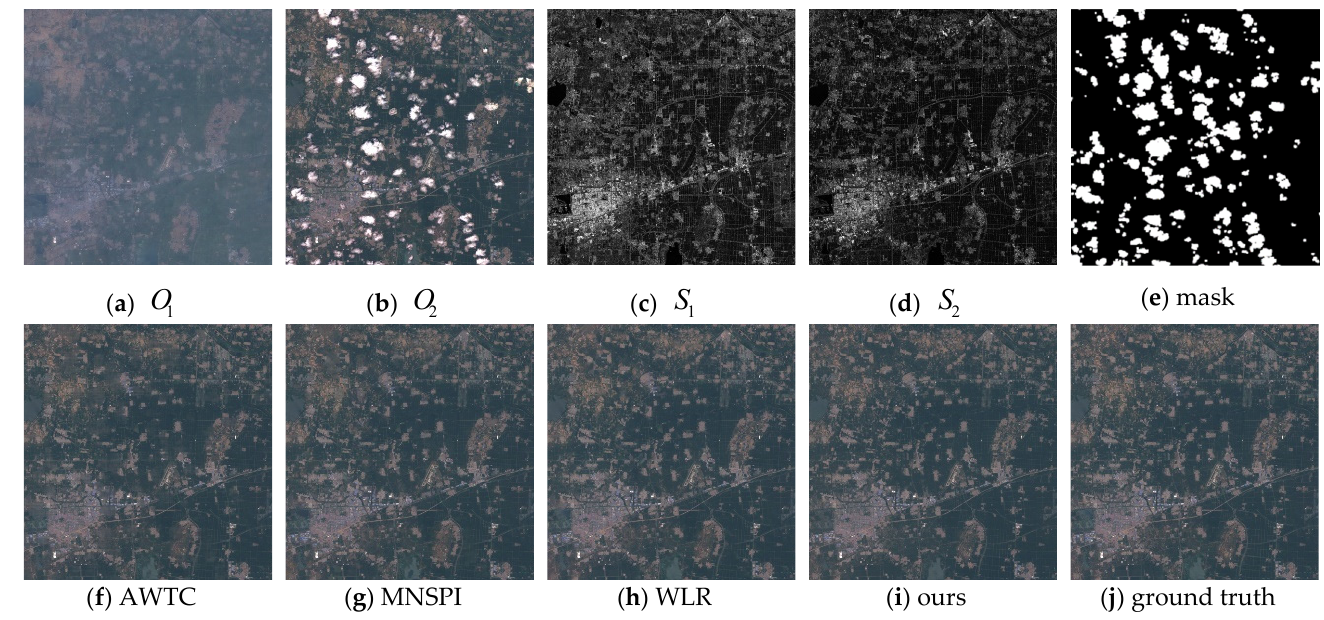
Figure 2. The global view of simulation experiment results.